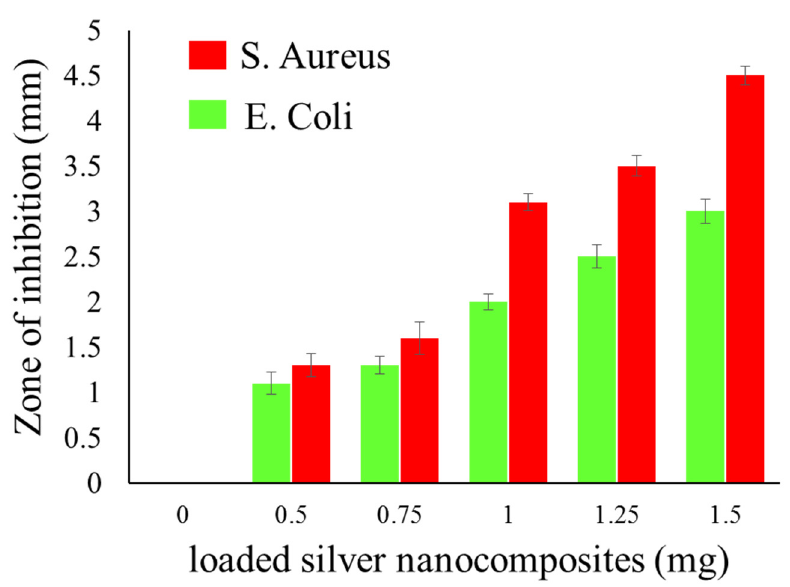
Figure 5. Summary of the antibacterial analysis of synthesized silver nanocomposites.